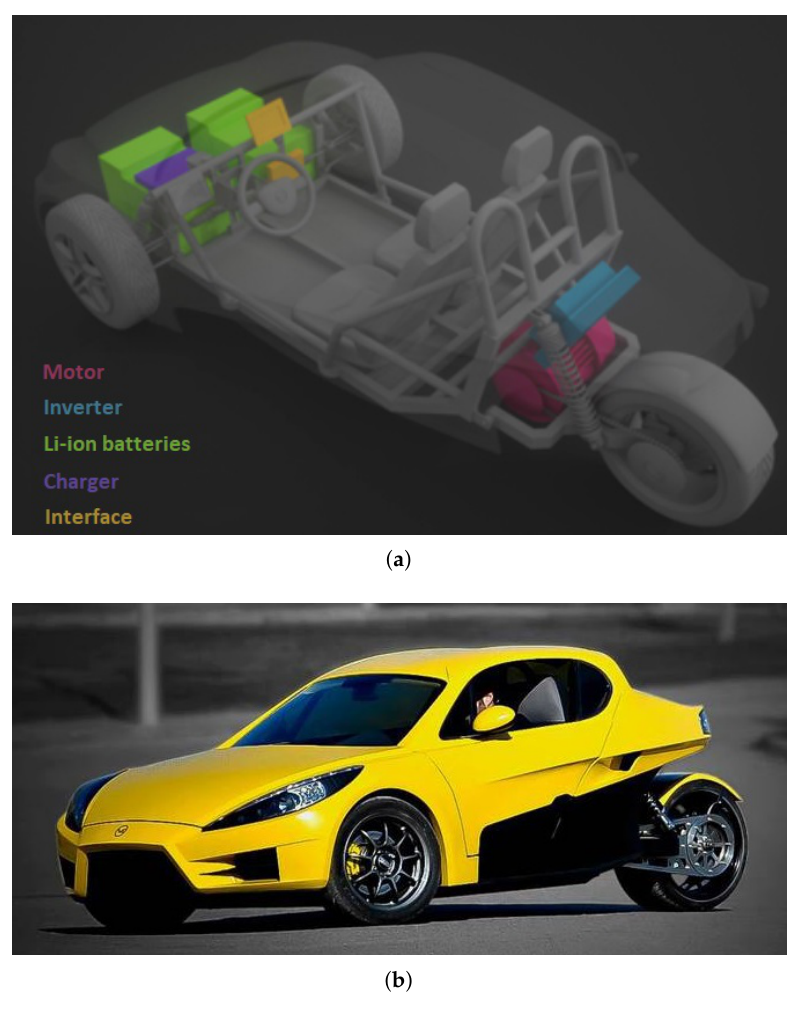
Figure 14. Model of the electric car VEECO. ( a ) Main component layout; ( b ) the VEECO RT. Table 3. Specification of the LiFePO 4 battery used in VEECO RT